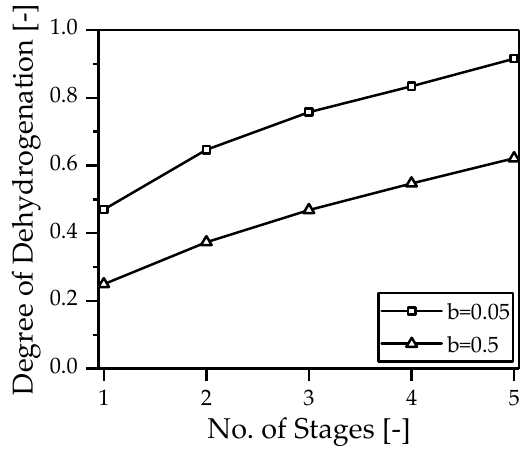
Figure 8. Degree of dehydrogenation as a function of the number of reactors used with intermediate separation at constant catalyst mass and varying influence of the gas phase on the effectively used catalyst mass.